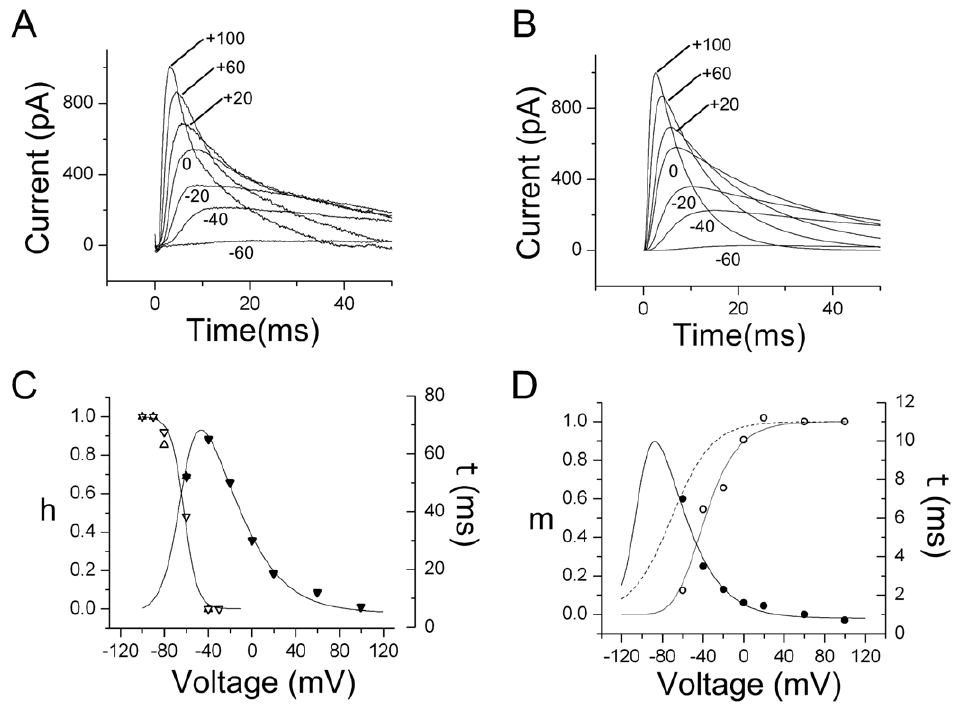
Figure 8. Biophysical characteristics of the I A current. A perforated patch on a P3 SN neuron that was later identified as a DA neuron. (A) I–V currents obtained with the same voltage-pulse protocol used in figure 3A. A small correction was used to account for a small difference in leak current. Voltage as indicated, the traces at 40 and 80 mV were excluded for clarity. (B) Fit to the currents on A was performed using a voltage-clamp simulator and solving Hodgkin-Huxley equations. (C) Inactivation parameters as a function of voltage. Open triangles, inactivation function, left ordinate. Closed triangles, time constant, right ordinate. The inactivation form was fit with a function of the form, h ? ~ 1 = (1 z exp ½ V h ~{ 62 + 4 : 5 , and K h ~ 6 + 2 (units in mV). The function to fit the time constant was t ( V ) ~ t 0 z ( t 1 = P 2 t 1 ~ 110 ms, V 1 ~{ 62, V 2 ~{ 31, K 1 ~ 9 , and K 2 ~ 27 (units in mV), b 1 ~{ 1, b 2 ~ 1 . This function is shown as the fit to the closed circles with